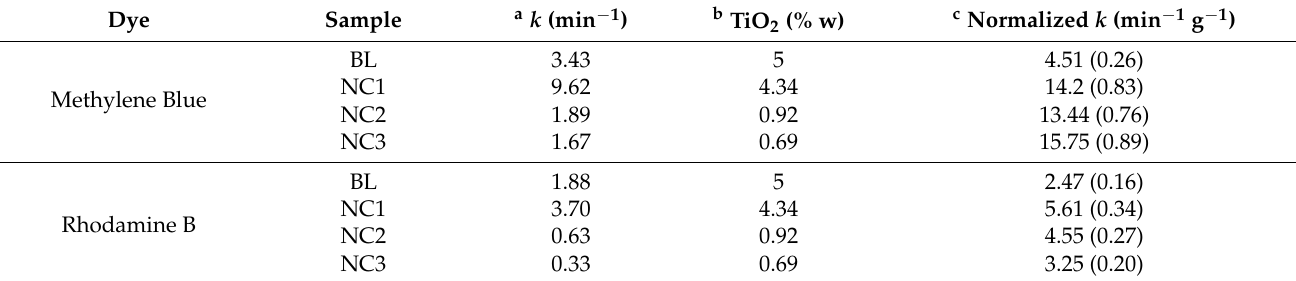
Table 1. Kinetics calculations related to MB and RhodB photodegradation employing different thin films: a kinetic constant; b nanocomposite’s TiO c kinetic constant k normalized by weight of 2 weight % content determined via colorimetric method; TiO 2 (standard errors are reported in